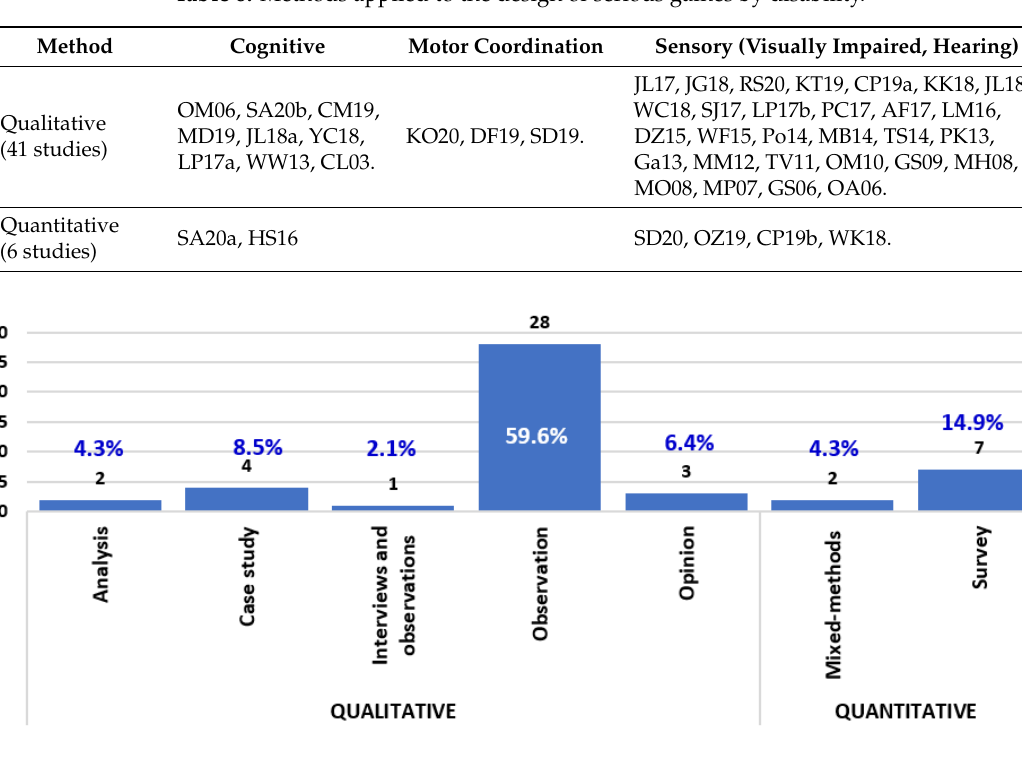
Table 9. Studies according to the type of research by disability.